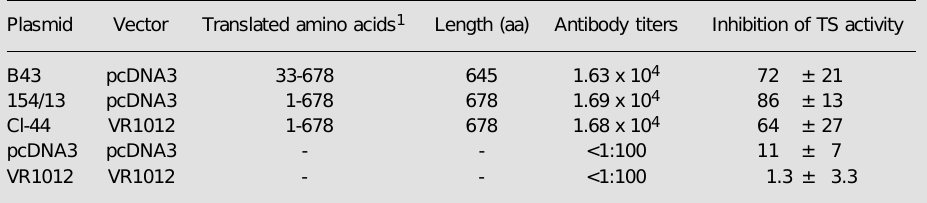
Table 1 - Antibody induction by immunization with TS plasmids. 1 Based on the sequence of gene TS 154 cloned from T. cruzi Y strain (17). Length is reported in terms of number of amino acid residues (aa).